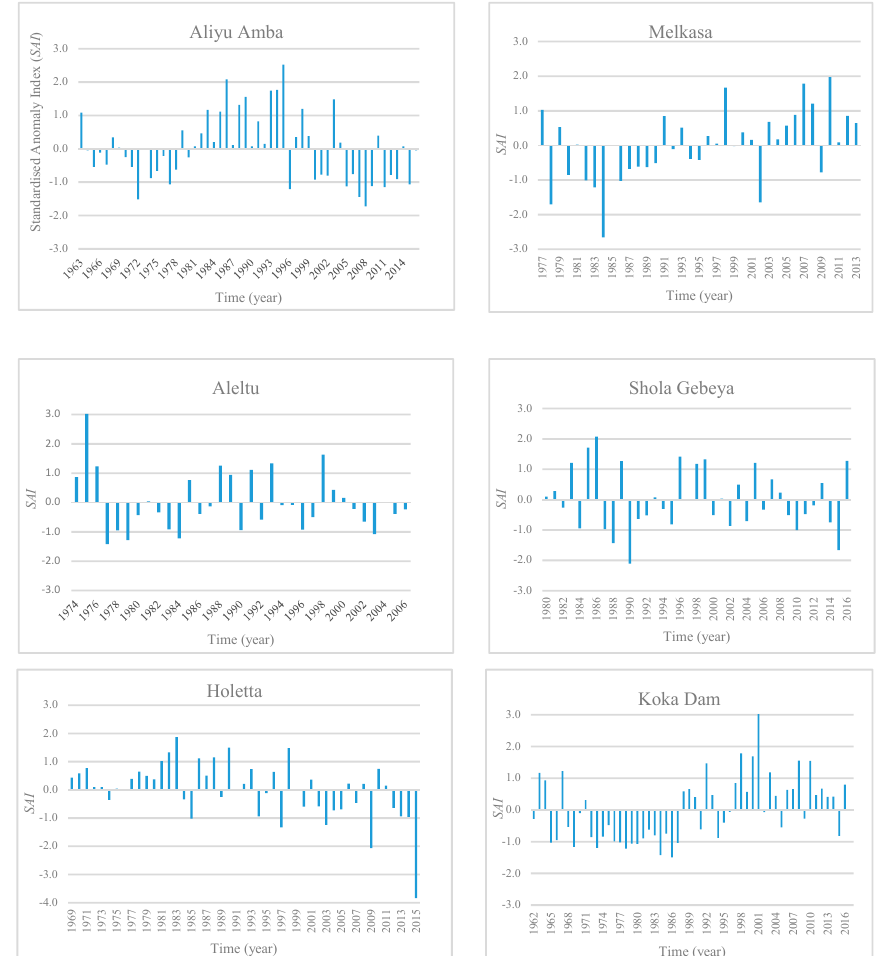
Figure 6. The annual standardised anomaly index ( SAI ) of rainfall in selected stations in the ARB .